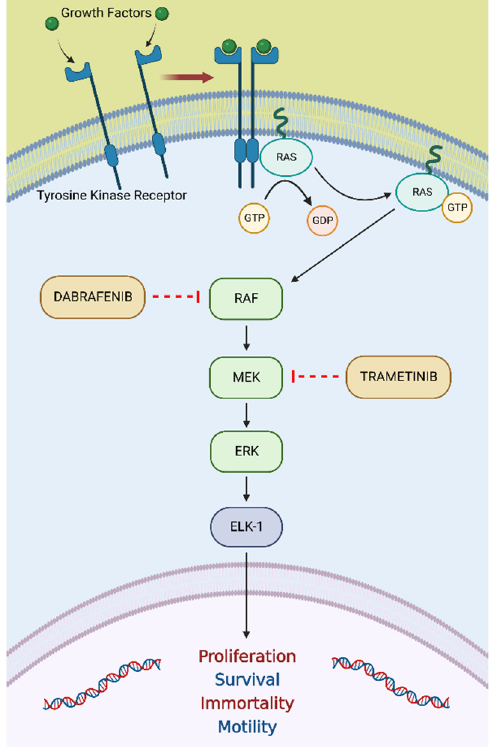
Figure 4. The RAS/RAF/MEK/ERK pathway is an essential molecular pathway among all MAPK signal transduction pathways and plays a crucial role in several cellular processes, including proliferation, differentiation, apoptosis, and stress responses. Abbreviations: ETS-like-1 (ELK-1); extracellular signal-regulated kinase (ERK); mitogen-activated protein kinase (MEK); rapidly accelerated fibrosarcoma (RAF); rat sarcoma virus (RAS). “Created with BioRender.com”.